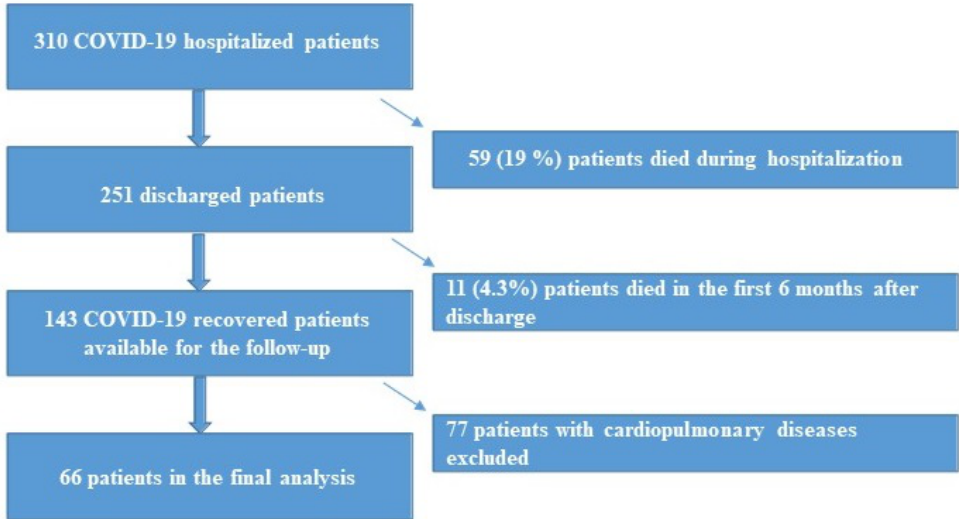
Figure 1. Schematic representation of the study population.